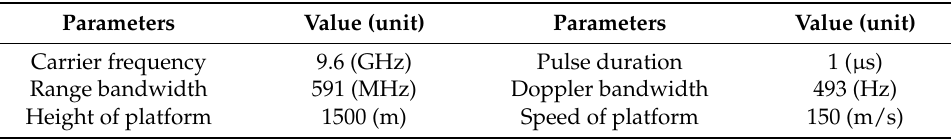
Figure 14. Spotlight SAR images of two targets on rough ground: ( a ) φ a = 15 ◦ ; ( b ) φ a = 30 ◦ ; ( c ) φ a = 45 ◦ ; ( d ) φ a = 60 ◦ . Table 3. Simulated spotlight SAR system parameters.